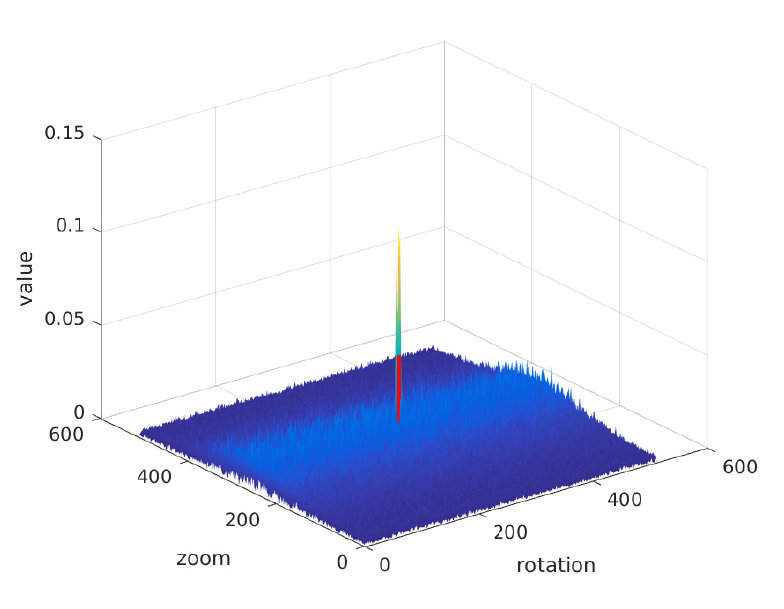
Figure 3. An example of rotation and zoom phase shift